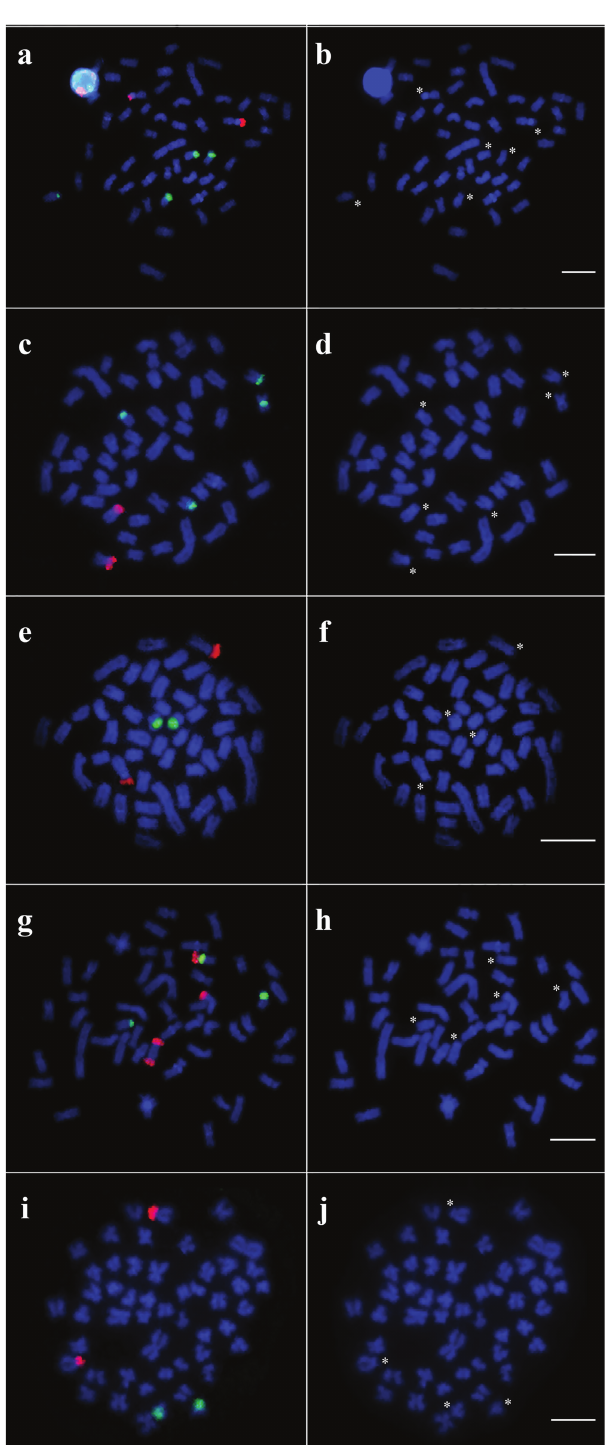
Fig. 5. Representative metaphases for each different pattern reported in populations of Nematocharax venustus showing the hybridization with 18S (magenta) and 5S rDNA probes (green) (double-FISH) and only DAPI staining for (a, b) Almada, Gongogi 1, and Jequitinhonha 1; (c, d) Gongogi 3; (e, f) Gongogi 2; (g, h) Jequitinhonha 2; and (i, j) Upper Contas. The asterisks indicate the chromosomes marked by FISH. Bars = 5